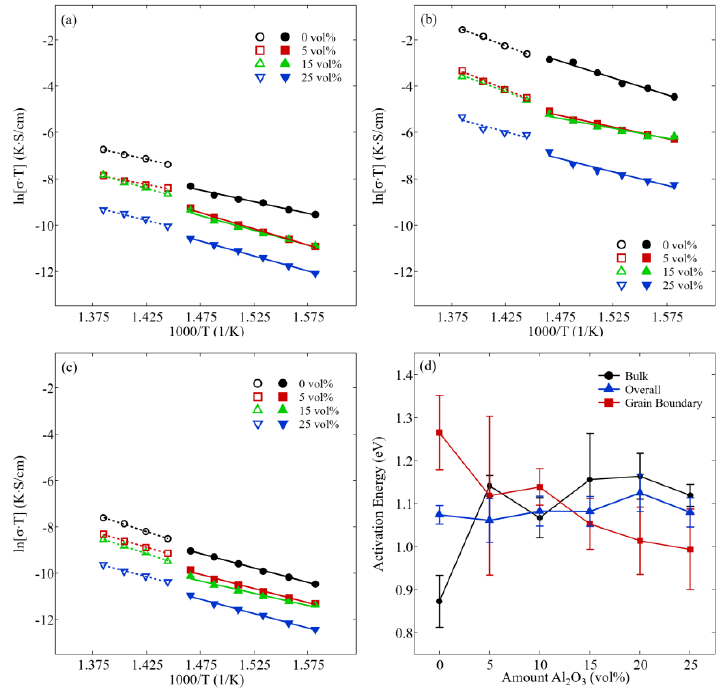
Figure 5. Arrhenius plots of the conductivity for various composites with varying amounts of Al 2 O 3 for bulk ( a ), grain boundary ( b ), and overall conductivity ( c ). The activation energies are shown for bulk, grain boundary, and overall in ( d ). Error bars were calculated from the standard deviation given during the fitting process.